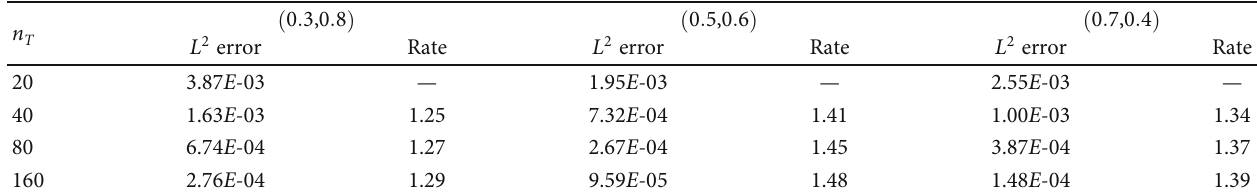
Table 2: The L 2 -norm errors in time for smooth case in Example 1 with h = 1/64 .